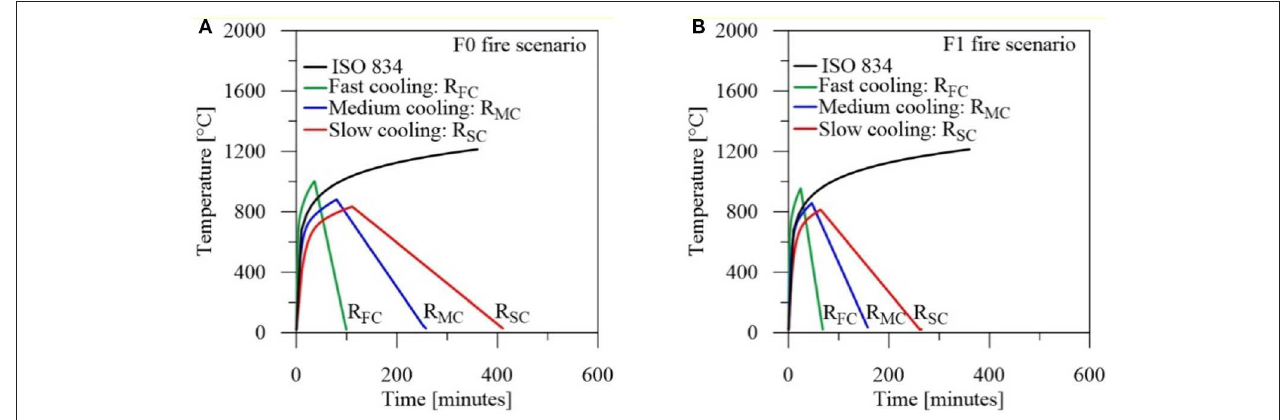
FIGURE 3 | Time-temperature curves for the Collina-Castello school. (A) F0 fire scenario. (B) F1 fire